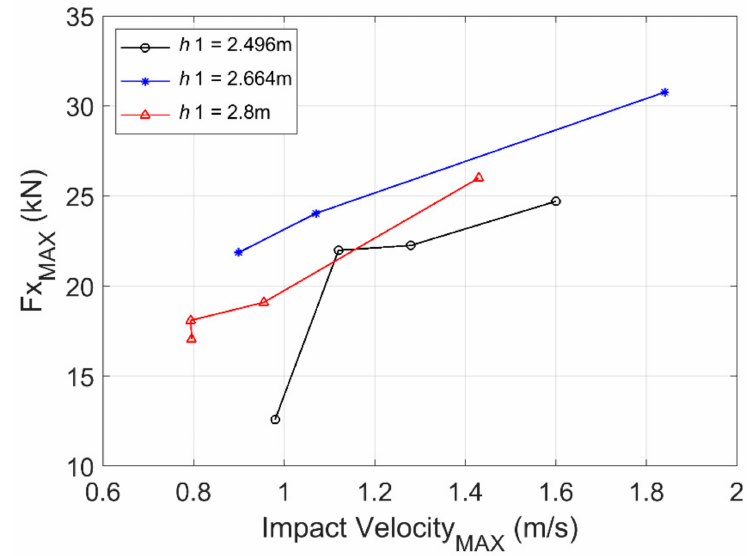
Figure 18. Maximum values of the debris impact force as a function of the impact velocity for three water depths and nine tsunami